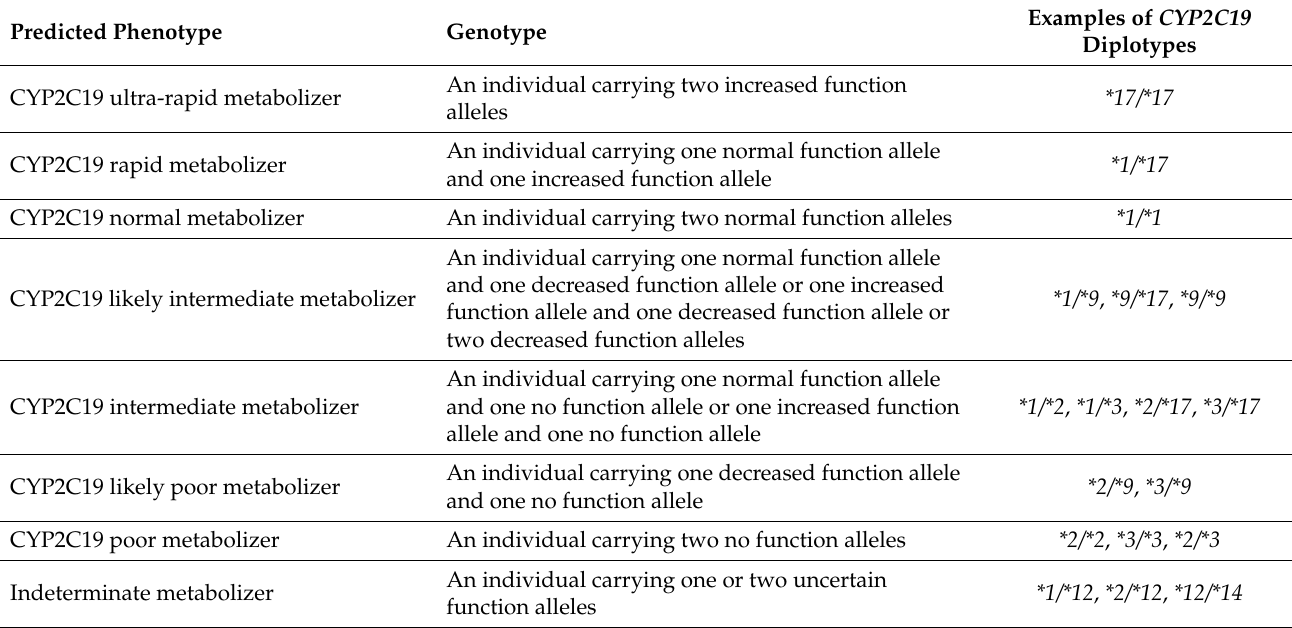
Table 1. The predicted CYP2C19 phenotype based on